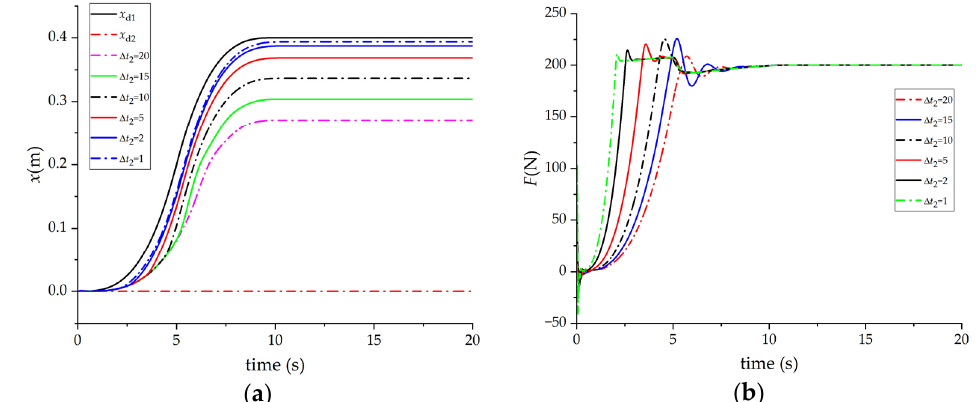
Figure 15. The influence of ∆ t 2 on the final position of the virtual object: ( a ) position profiles of a